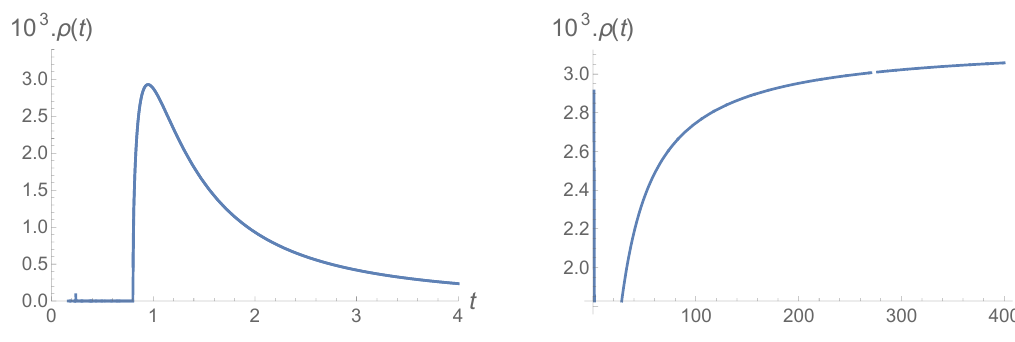
Figure 13 . Spectral function for the reduced elementary propagator h h ( p ) h ( (cid:0) p ) i for small values of t (left) and large values of t (right), with all quantities given in units of appropriate powers of the energy scale (cid:22) , for (cid:24) = 1000 the parameter values e = 1, v = 1 (cid:22) , (cid:21) = 1